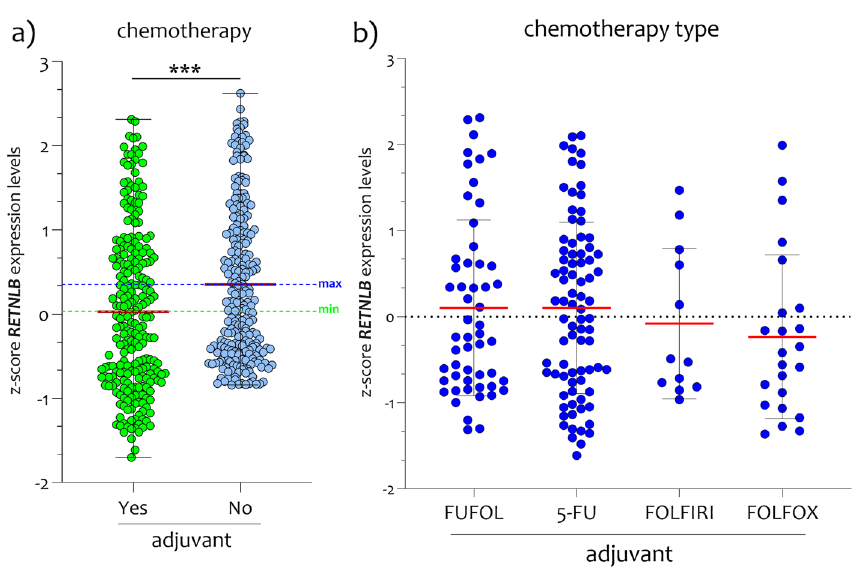
Figure 5. RETNLB expression levels correlate to treatment of patients with CRC with adjuvant chemotherapy. ( a ) RETNLB levels are reduced in biopsies from CRC patients during adjuvant chemotherapy treatment; ( b ) RETNLB expression levels in CRC patients’ biopsies with different adjuvant chemotherapy treatments (5-fluorouracil (5-FU), folinic acid (FUFOL), irinotecan (FOLFIRI), and oxaliplatin (FOLFOX)). The dashed lines indicate the maximum and minimum mean values. Data are expressed as z-score intensity expression levels (means and SD) and presented as dot plots. p values < 0.05 were considered as statistically significant (***p <